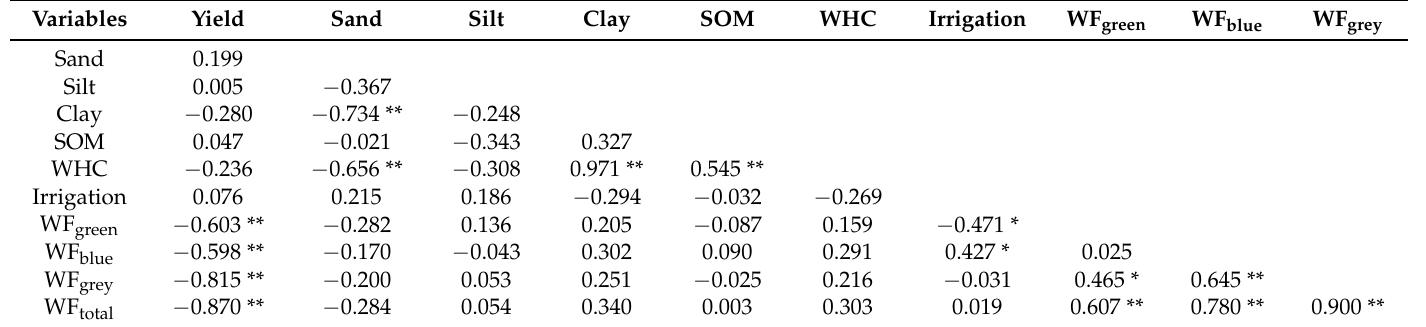
Table 4. Pearson Correlations of Water Footprint component with yield, irrigation volumes and selected soil properties. Variables Yield Sand Silt Clay SOM WHC